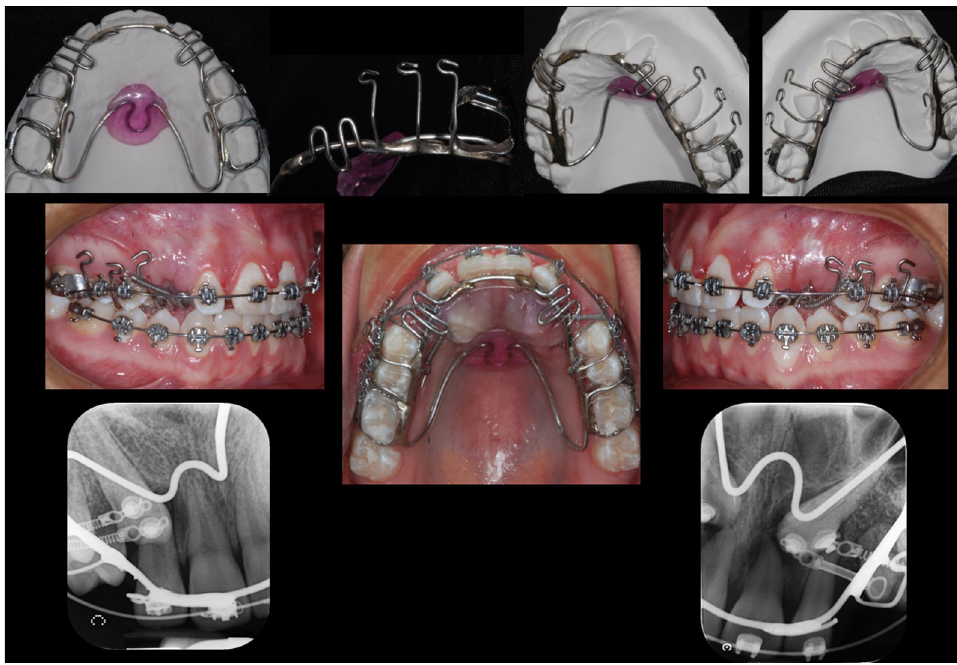
Fig 7. Rigid Anchorage appliance used for MIC